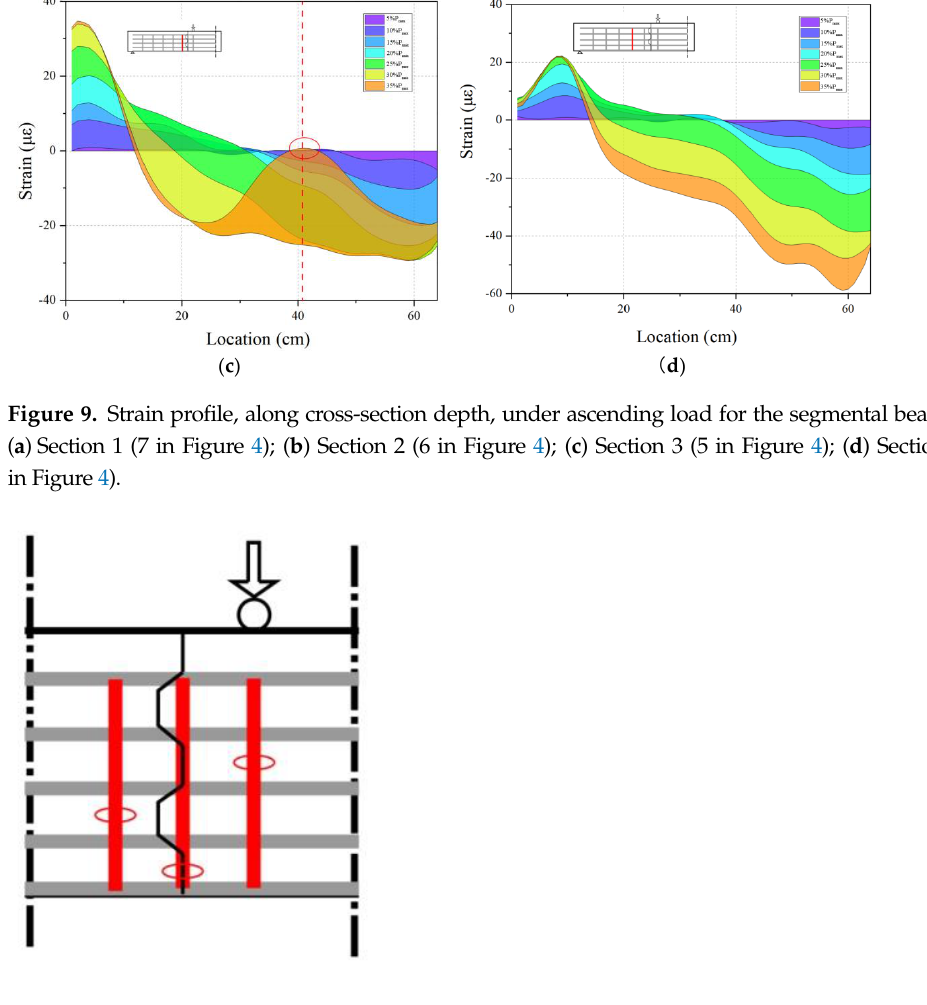
Figure 10. Location of cracks close to the shear keys in the segmental